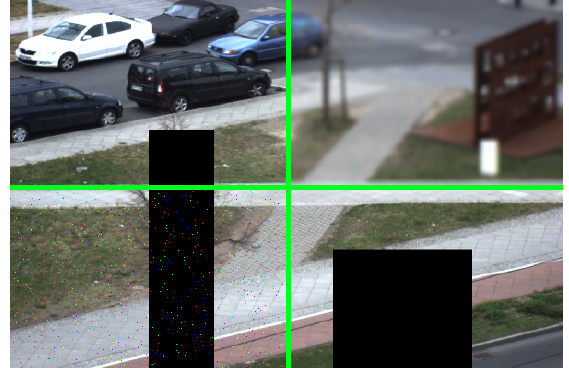
Figure 5: Sample images from four tests: upper left - ”normal”, upper right - ”blur”, lower left - ”noise”, lower right - ”more oc- clusion”. For tracking results see Table 1